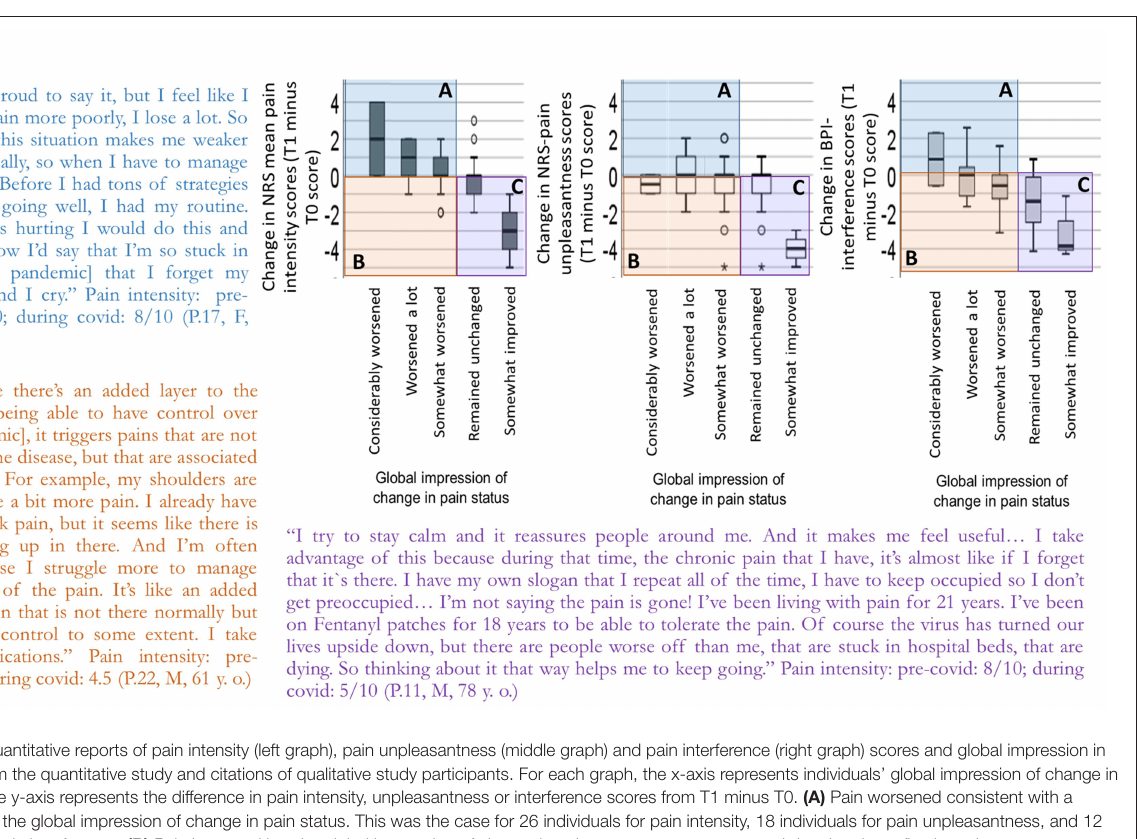
FIGURE 3 | Quantitative reports of pain intensity (left graph), pain unpleasantness (middle graph) and pain interference (right graph) scores and global impression in pain status from the quantitative study and citations of qualitative study participants. For each graph, the x-axis represents individuals’ global impression of change in pain status. The y-axis represents the difference in pain intensity, unpleasantness or interference scores from T1 minus T0. (A) Pain worsened consistent with a deterioration in the global impression of change in pain status. This was the case for 26 individuals for pain intensity, 18 individuals for pain unpleasantness, and 12 individuals for pain interference. (B) Pain improved but the global impression of change in pain status suggests a general deterioration reflecting other pain/stress-related factors. This was the case for 6 individuals for pain intensity, 14 individuals for pain unpleasantness, and 20 individuals for pain interference. (C) Pain improved and global impression of change in pain status suggests stability or some improvement. This was the case for 7 individuals for pain intensity, 9 individuals for pain unpleasantness, and 13 individuals for pain interference. The qualitative study allowed to identify similar profiles of participants that provide context to those